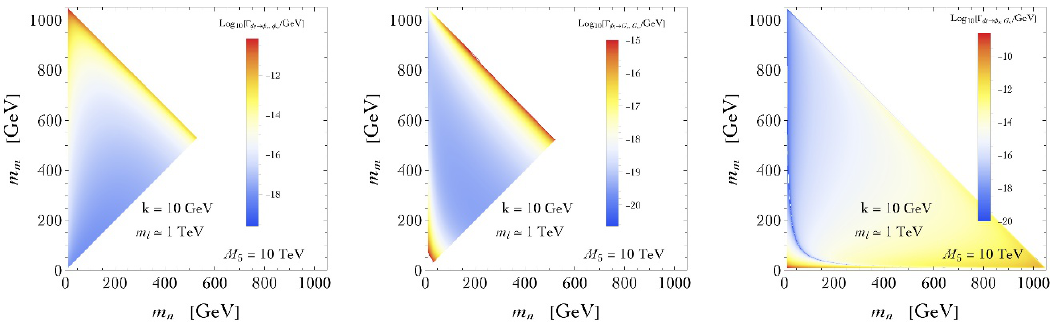
(left panel), (cid:0) (cid:30) (central panel) and l ! (cid:30) m (cid:30) n l ! G m G n